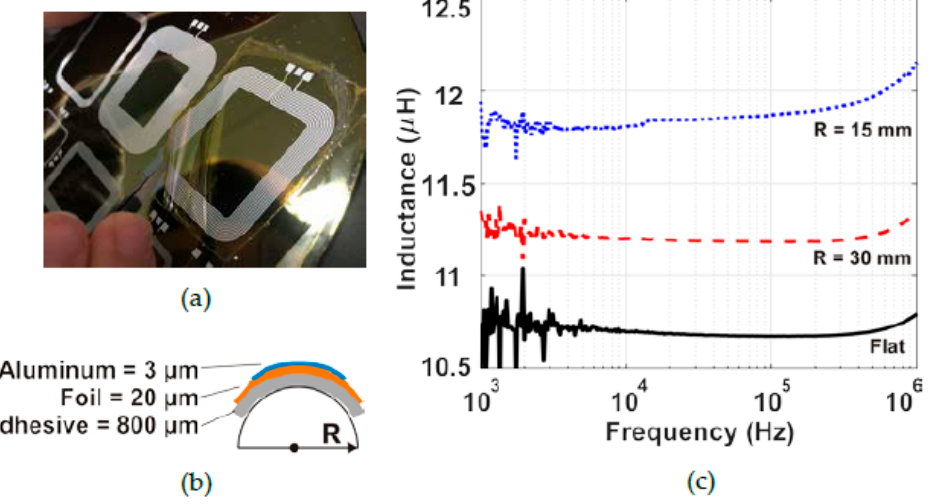
Figure 4. The on-foil inductors. ( a ) Mechanical release of the inductors from the carrier wafer. ( b ) Illustration of the foil stack during bending, while highlighting each layer thickness. ( c ) Electrical characterization using LCR meter at different bending